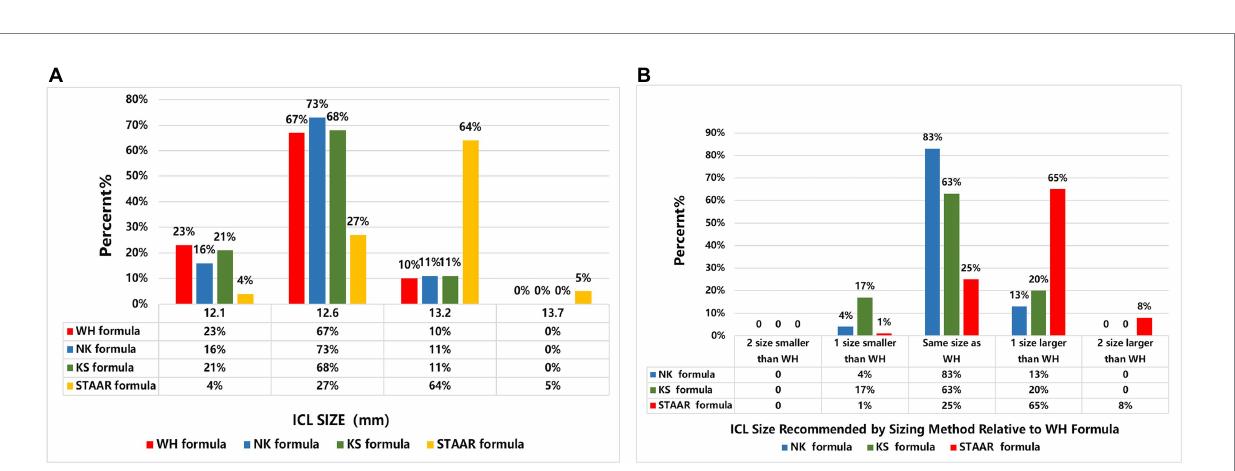
FIGURE 5 Comparison of recommended size for WH, NK, KS, and STAAR formula. (A) Frequency histogram of Implantable Collamer Lens (STAAR Surgical) size used based on WH formula versus size recommended by each of the principal published sizing methods (NK, KS, and STAAR). (B) Comparison of